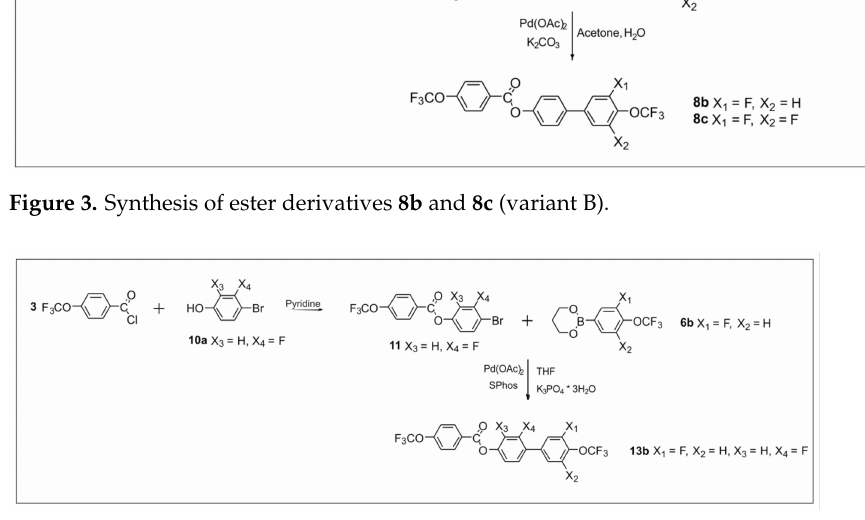
Figure 4. Synthesis of 2,3 (cid:48) -difluoro-4 (cid:48) -(trifluoromethoxy)-[1,1 (cid:48) -biphenyl]-4-yl 4-(trifluoromethoxy) benzoate 13b .